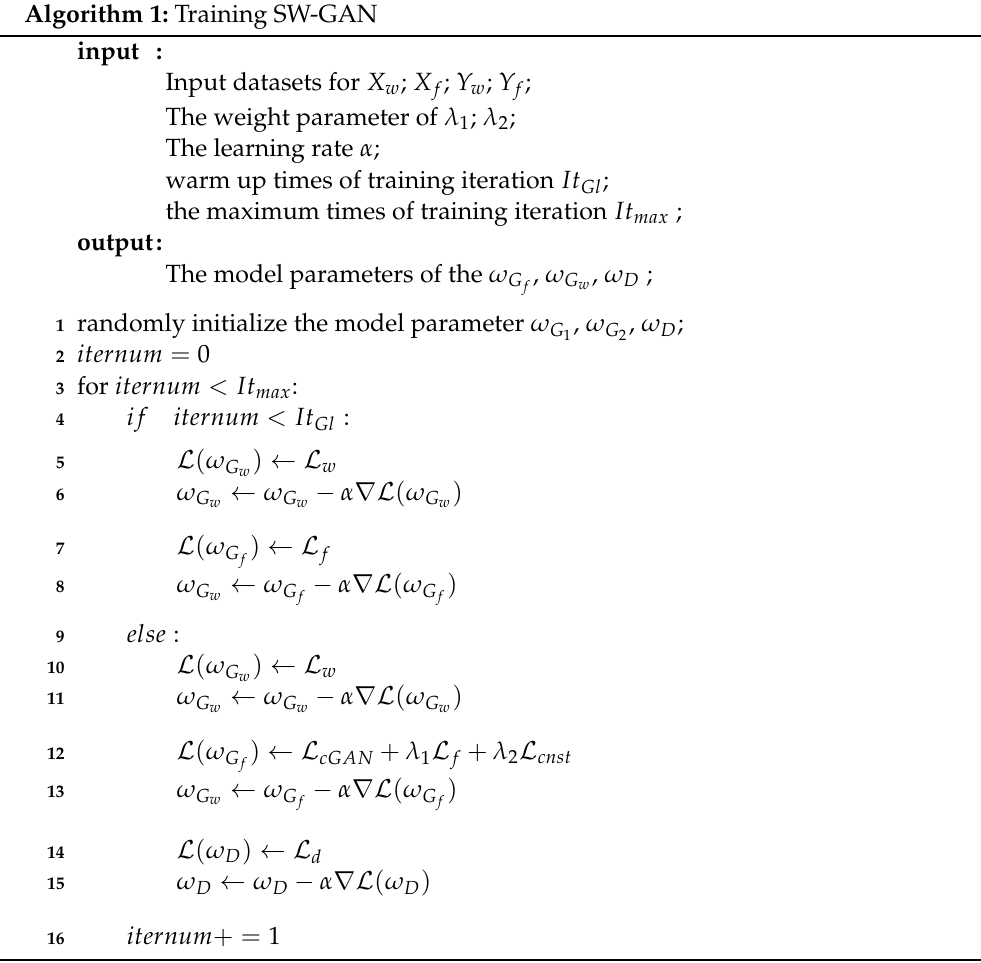
Algorithm 1: Training